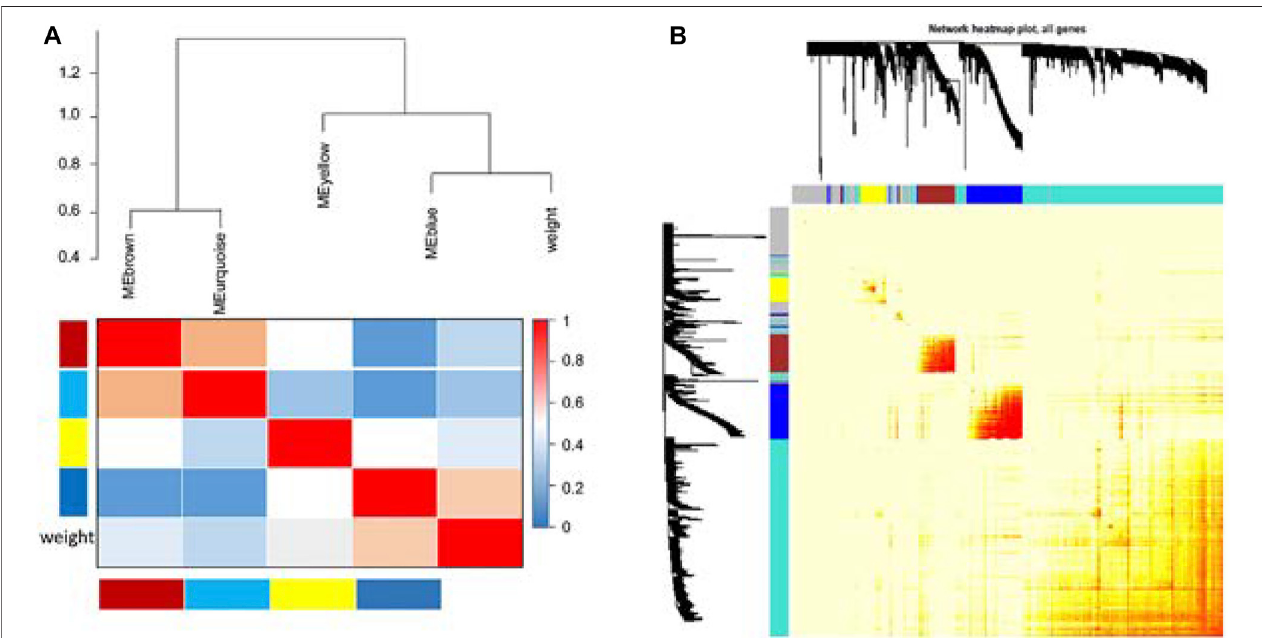
FIGURE 3 | Comparisons between four modules. Genes in the blue module have the highest correlation (A) . Average linkage hierarchical clustering with the topological overlap dissimilarity measure was used to identify gene co-expression modules. The gene network was visualized using a heatmap plot. Light color representslowoverlap,whiletheprogressivelydarkerredcolorrepresentshigheroverlap.Blocksofdarkercolorsalongthediagonalarethemodules.Genedendrogram and module assignment are also shown along the left side and at the top (B) .